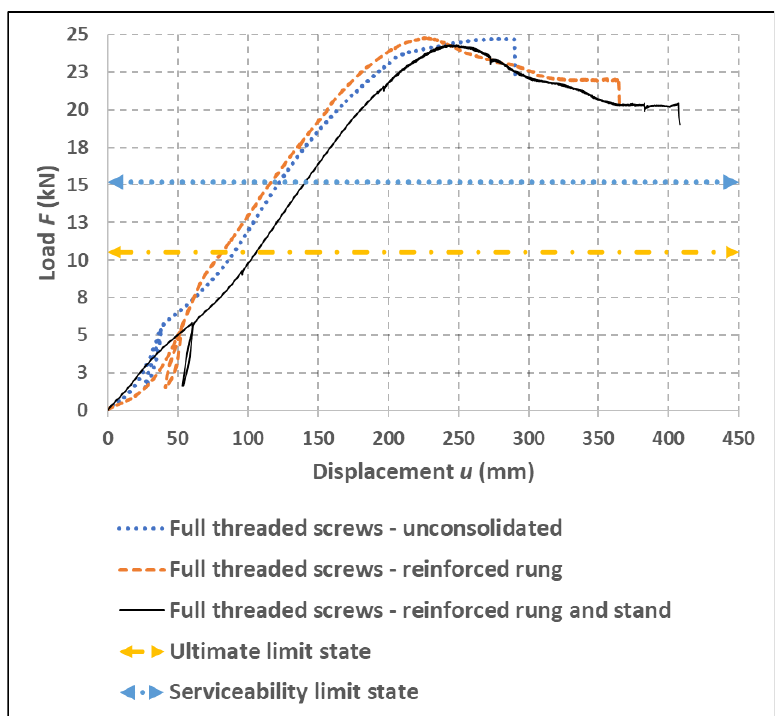
Figure 15. Load – deformation curves of individual specimens of static cyclic stress of experiment A, using bolts and dowels.